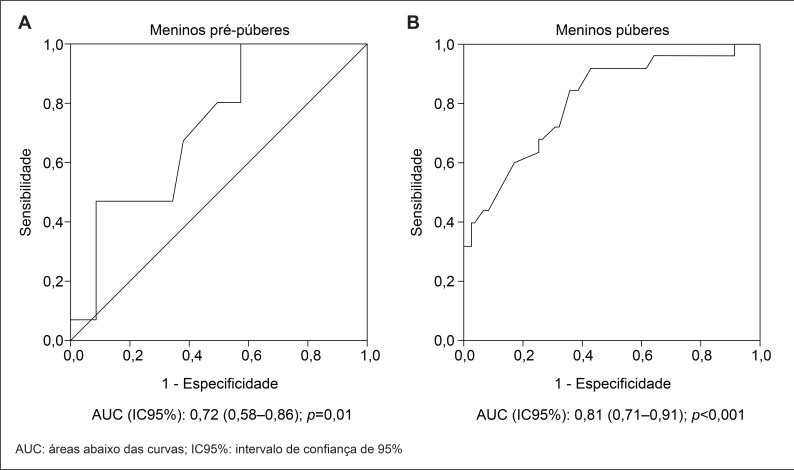
Curva ROC para a circunferência do pescoço na avaliação da resistência à
insulina em adolescentes do sexo masculino pré-púberes (A) e púberes
(B)